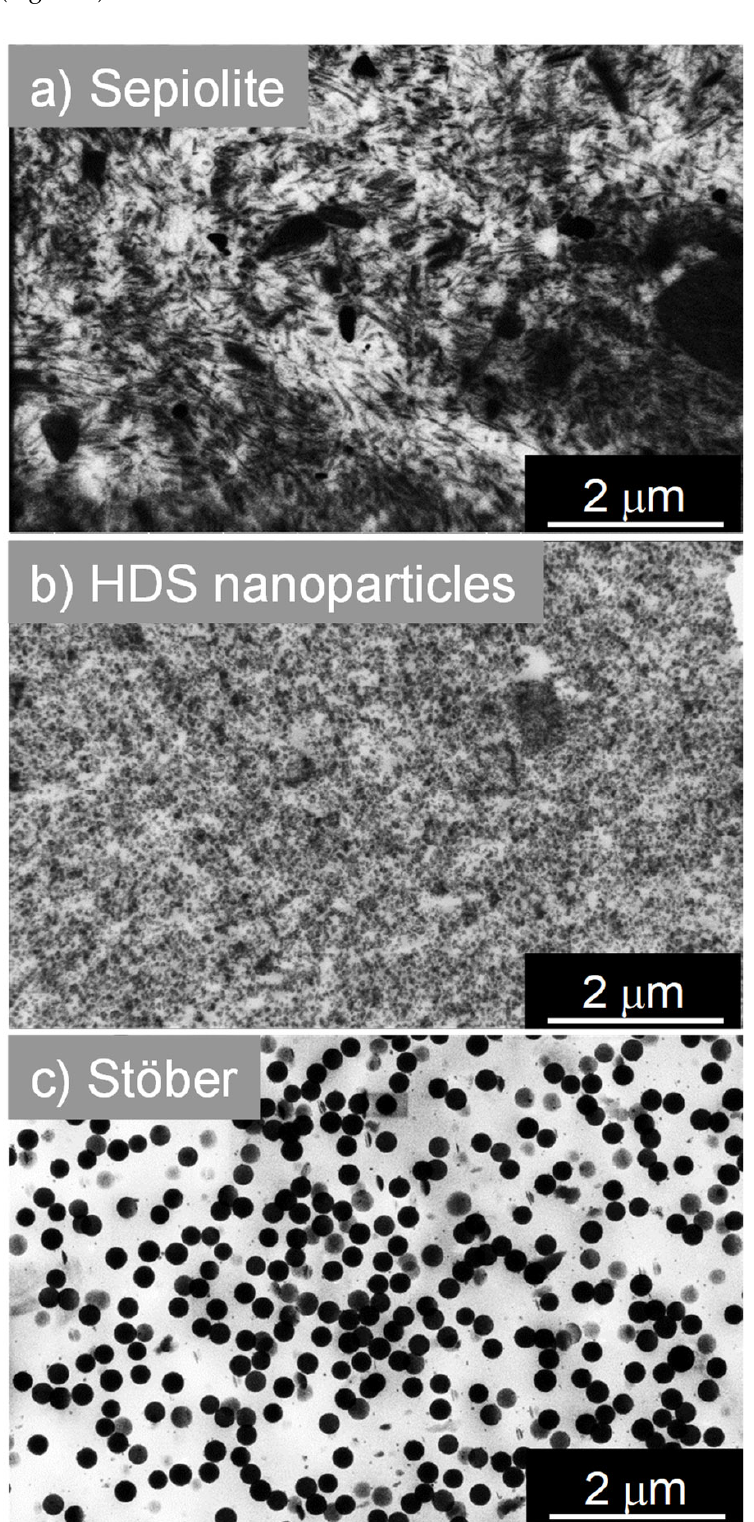
Figure 1. STEM images of reference nanocomposites synthesized with 80 phr of one type of filler only: ( a ) Sepiolite, ( b ) HDS, and ( c ) Stöber nanoparticles (250 nm).